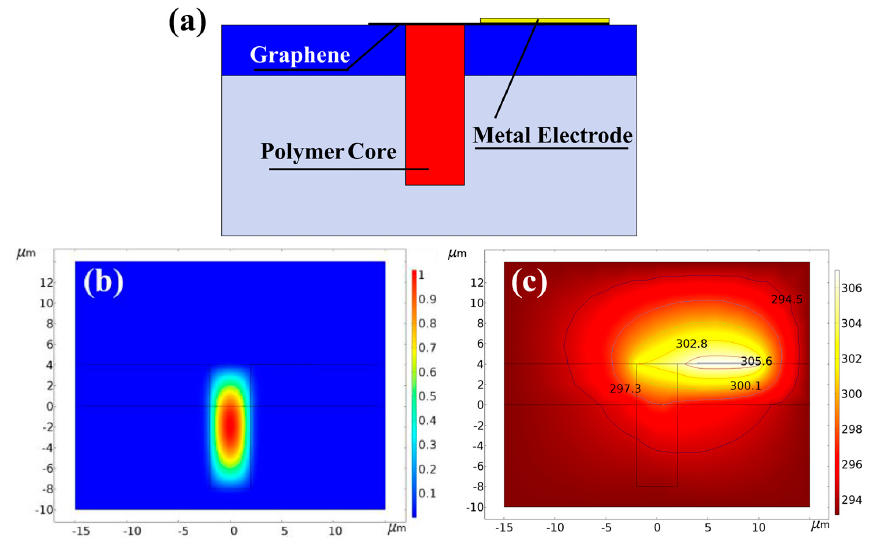
Figure 8. ( a ) The cross-section of VOA with graphene electrodes. ( b ) Optical field distribution in the heating region. ( c ) Thermal field distribution in the heating region.